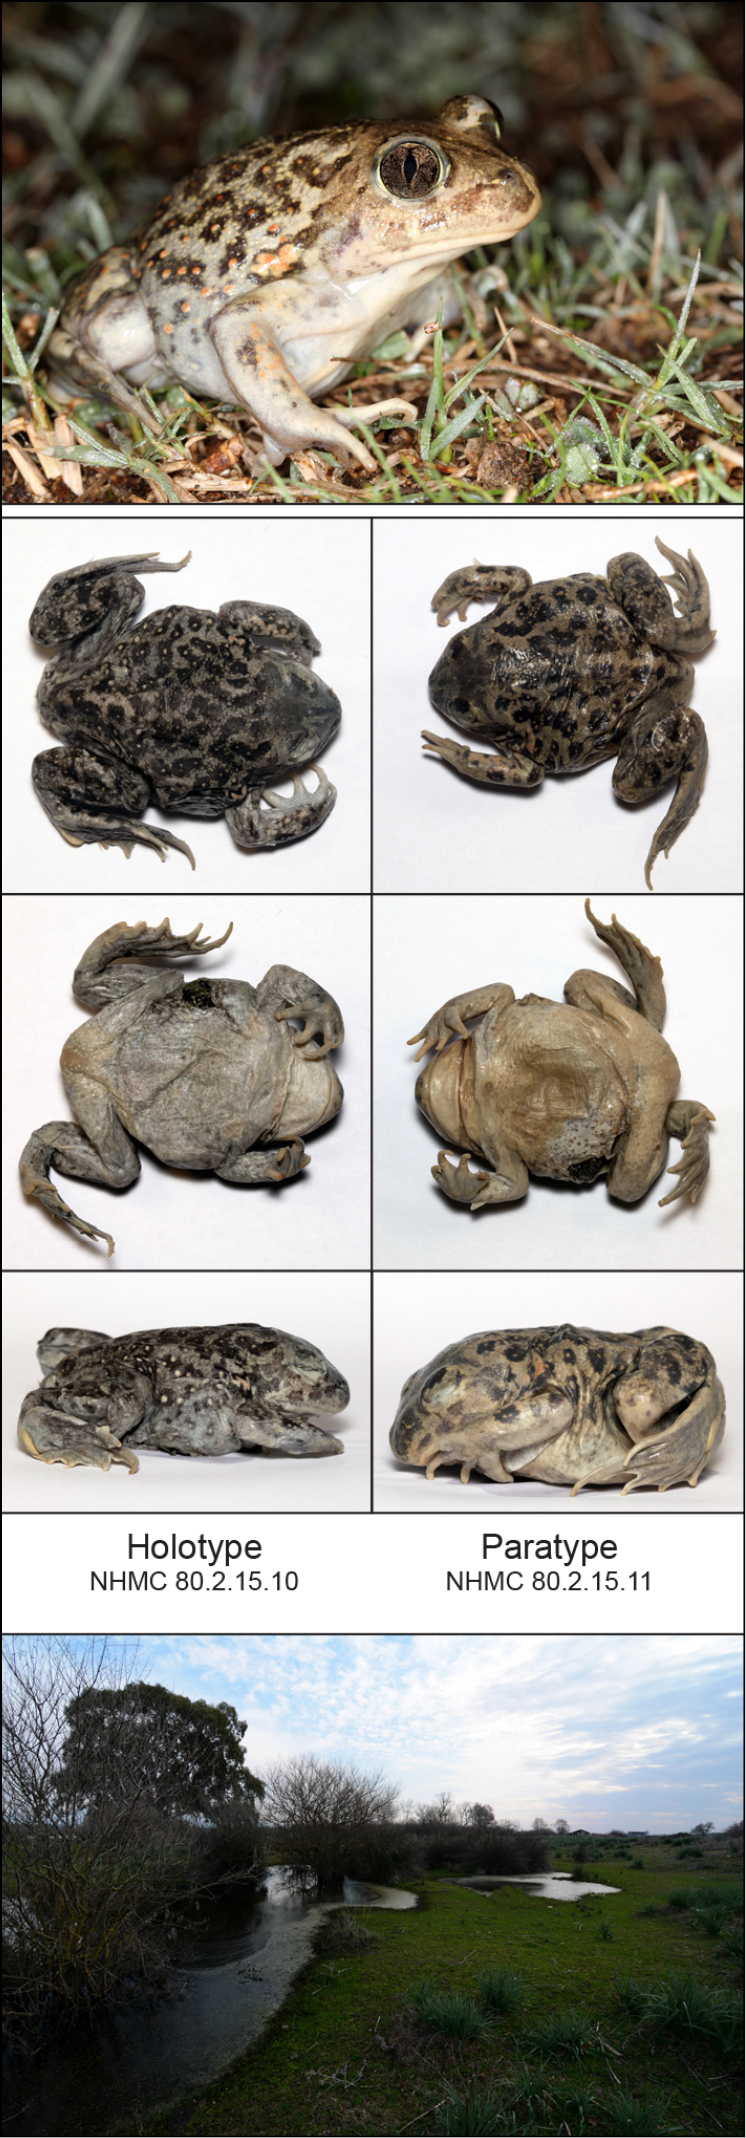
Description of Pelobatesbalcanicuschloeae. Top live photograph of the holotype, NHMC 80.2.15.10 (CD, taken on December 10th 2018); middle dorsal and lateral views of the type specimens (left NHMC 80.2.15.10; right NHMC 80.2.15.11) post-mortem (IS); bottom Strofylia meadows, the type locality in Peloponnese, Greece (ET).